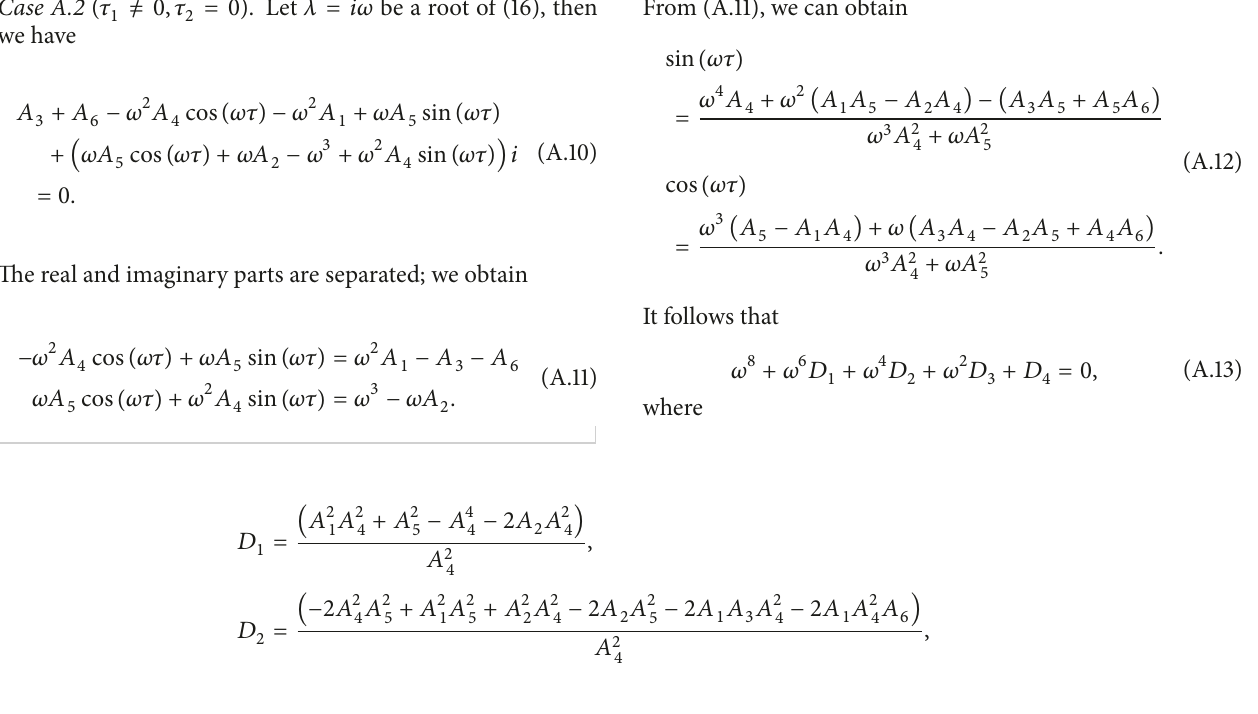
𝐾 = 1.2, 𝜏 = 0.01 s, and 𝜏 = 𝜏 𝑃 1 2 2∗